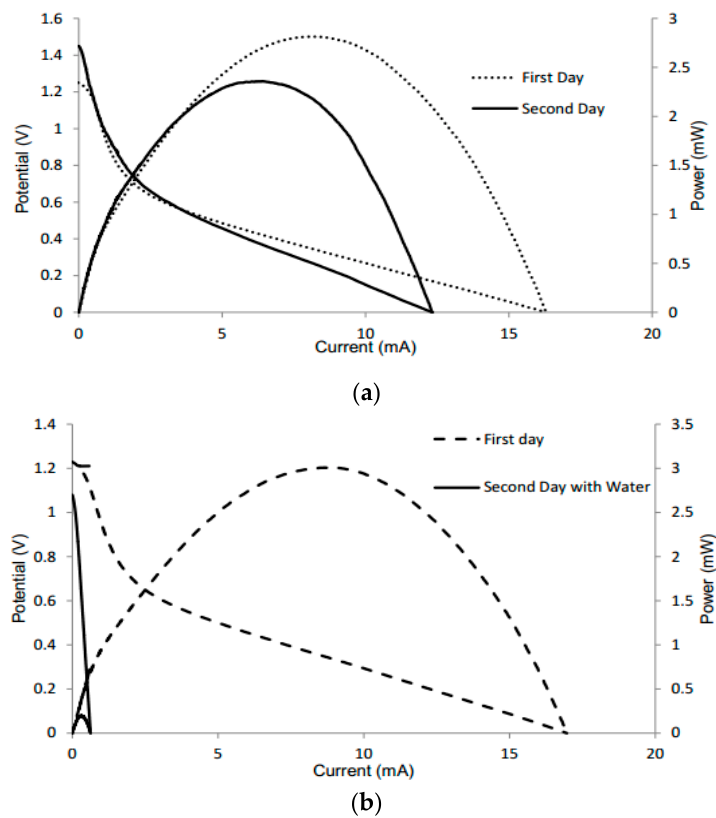
Figure 4. Polarization curves of different batteries tested the first day with KOH and the following day with ( a ) electrolyte and ( b ) water.